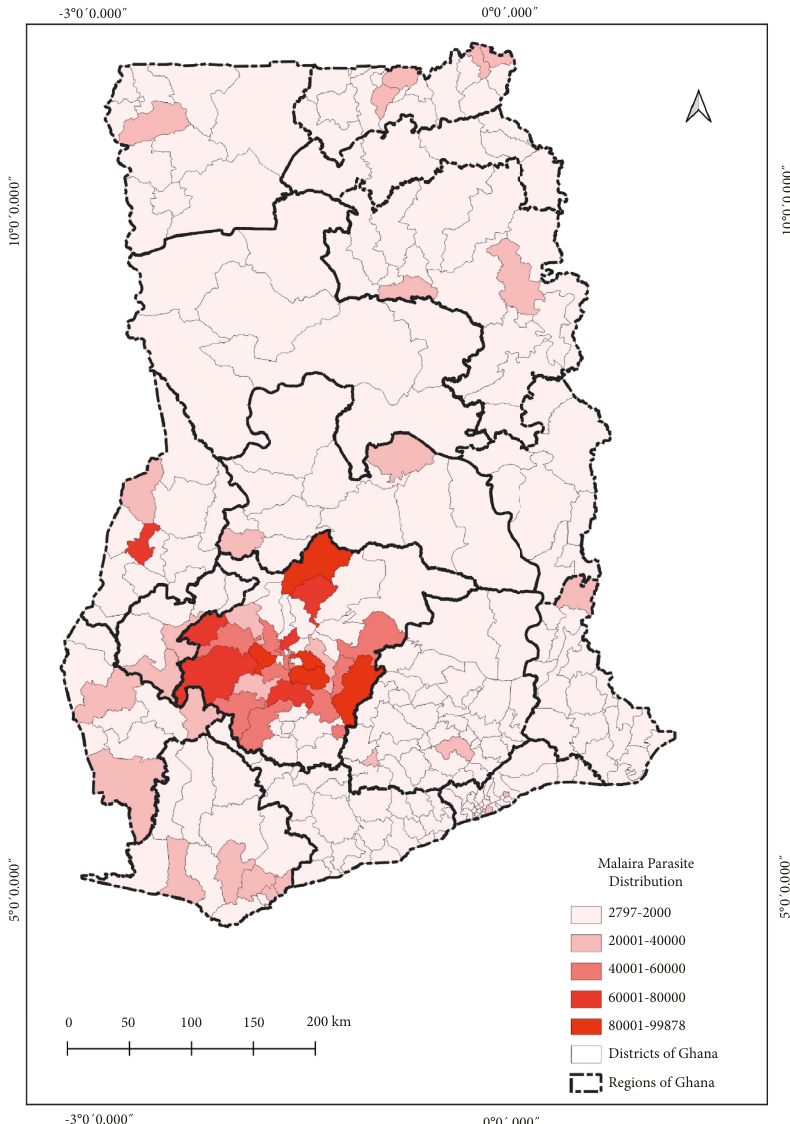
Figure 5: Distribution and intensity of malaria parasite pathogens in Ghana for the year 2020. The legend indicates the sum of malaria cases recorded from health facilities in each district across the country. For instance, 2,797 was the least number of cases recorded from a district and 99,878 was the highest number of cases recorded from a district within the period of January to December 2020. The intensity classifications were generated based on quantile to assign the same number of data values to each class from the ArcGIS software used to develop the